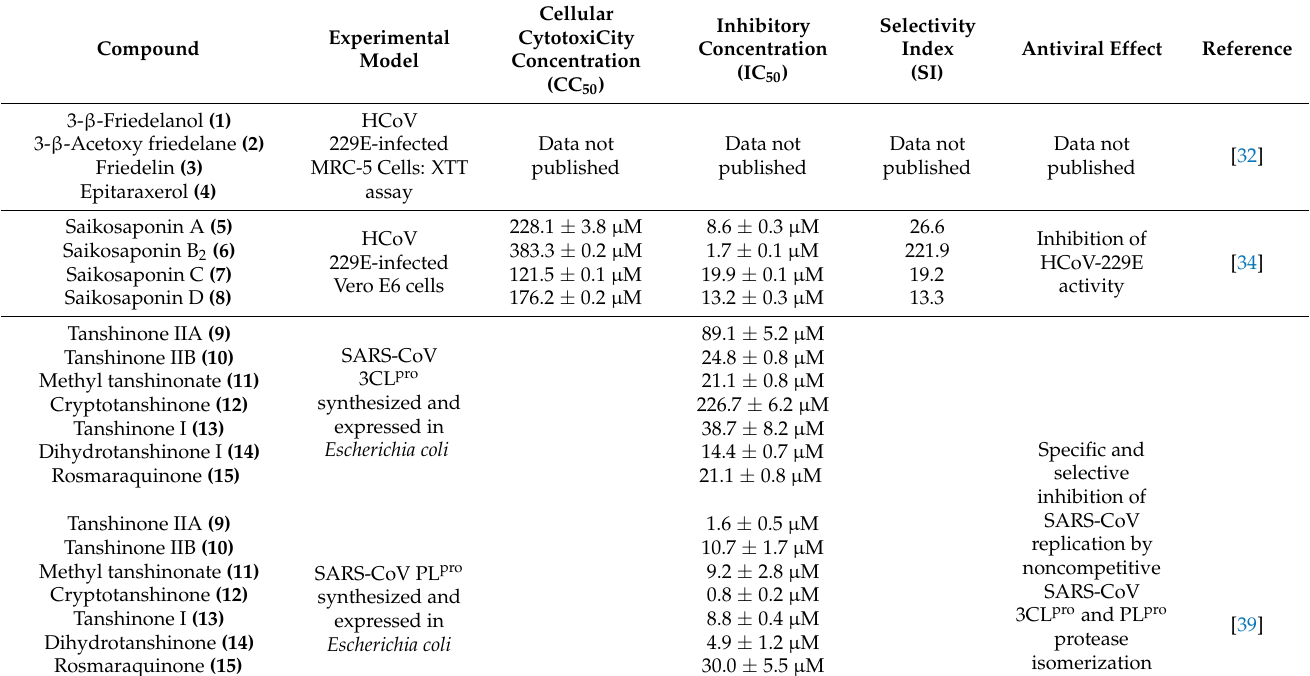
Figure 1. Chemical structure of bioactive terpenes against coronavirus. Table 1. Terpenes and derivatives tested against in vitro coronavirus infection models, their main results, and mechanism of